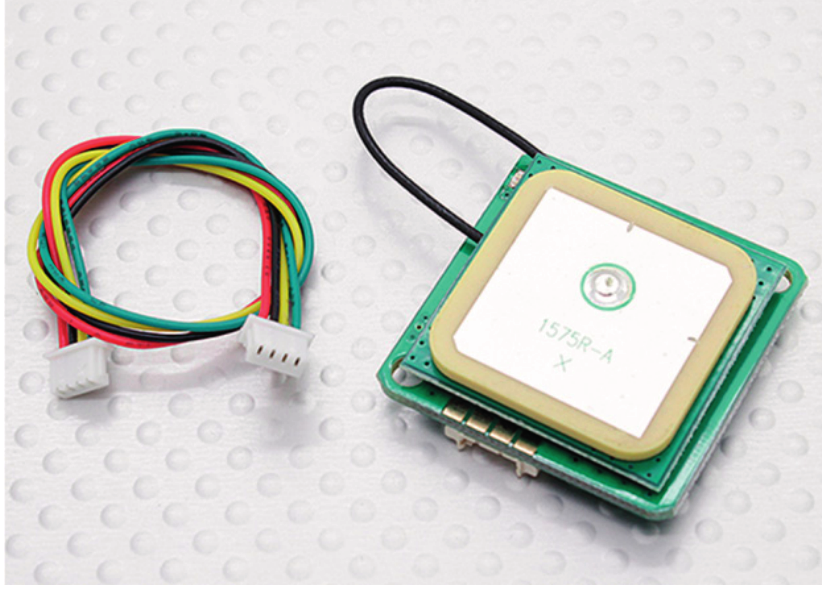
Figure 3. The UBlox 6M GPS